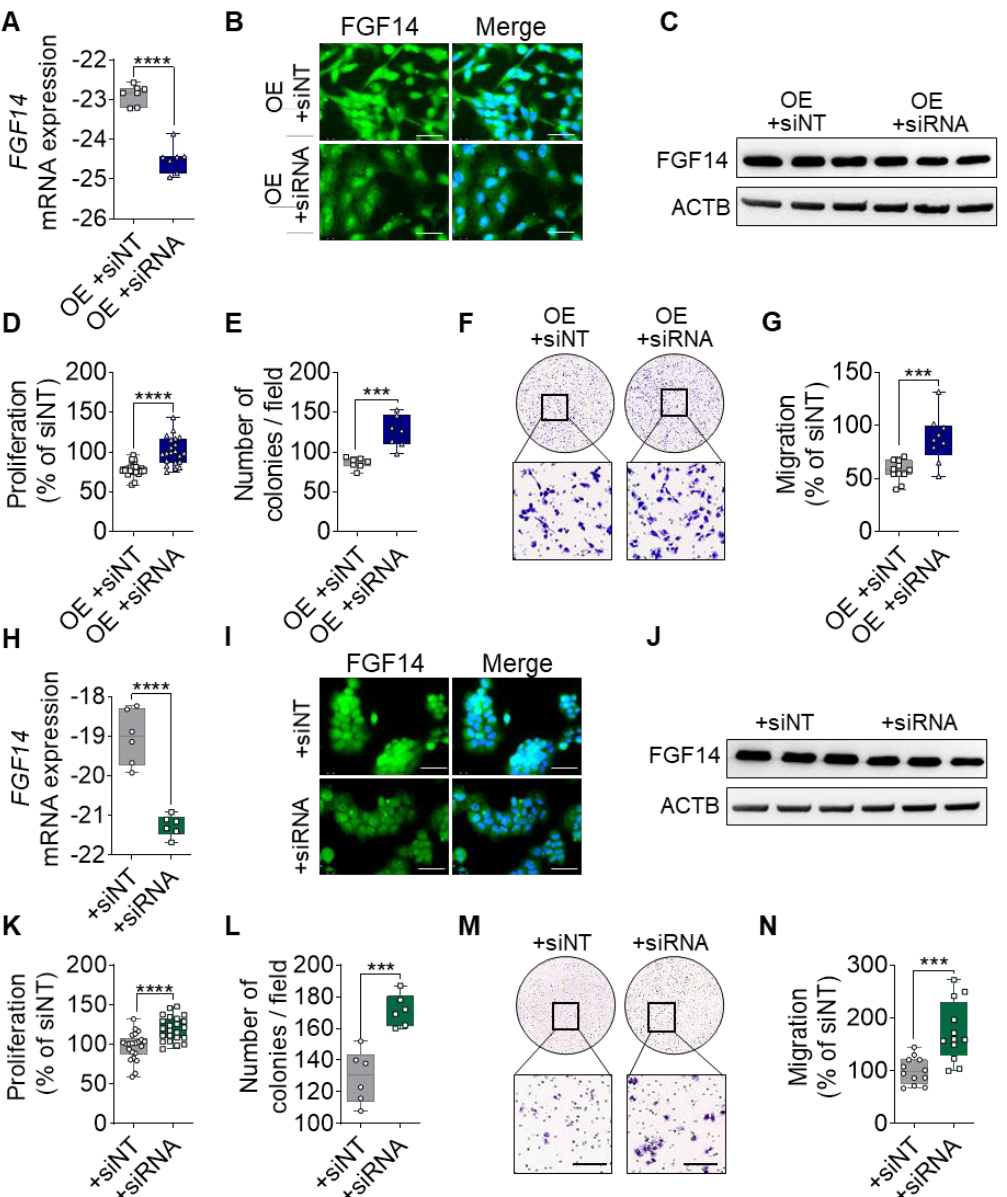
Figure 3. Silencing of FGF14 abrogate the suppressive phenotype in FGF14 overexpressing A549 cells. ( A ) mRNA expression of FGF14 after siRNA transfection with FGF14 siRNA and non-targeting siRNA control (siNT). ( B ) ICC images of FGF14 after treatment with FGF14 siRNA compared with non-targeting control. Cells were labeled by using antibody against FGF14 and detected using AlexaFlour488 secondary antibody (green). Nuclear DNA was counterstained with DAPI (blue), scale bars, 50 µ m. ( C ) Western blotting of FGF14 OE cells after treatment with FGF14 siRNA. ( D ) Cellular proliferation by BrdU incorporation, ( E ) colony formation and ( F , G ) Boyden chamber migration was performed after treatment of FGF14 OE cells with siNT compared to FGF14 siRNA. ( H ) mRNA expression level of FGF14 in H460 cells after siRNA treatment. ( I ) Representative pictures of FGF14 ICC staining of siRNA and non-targeting siRNA treated H460 cells. ( J ) Western blotting of H460 cells after siRNA transfection. In vitro assays including ( K ) proliferation, ( L ) colony formation and ( M , N ) migration to determine functional changes upon FGF14 silencing. Data are shown as mean ± standard error of the mean using Student’s t -test ( n = 3). P -values ≤ 0.05 were considered statistically significant for all analyses. *** p ≤ 0.001 and **** p ≤ 0.0001. 3.4. Overexpression of FGF14 Reduces Tumor Progression in a Subcutaneous Xenograft Tumor Model